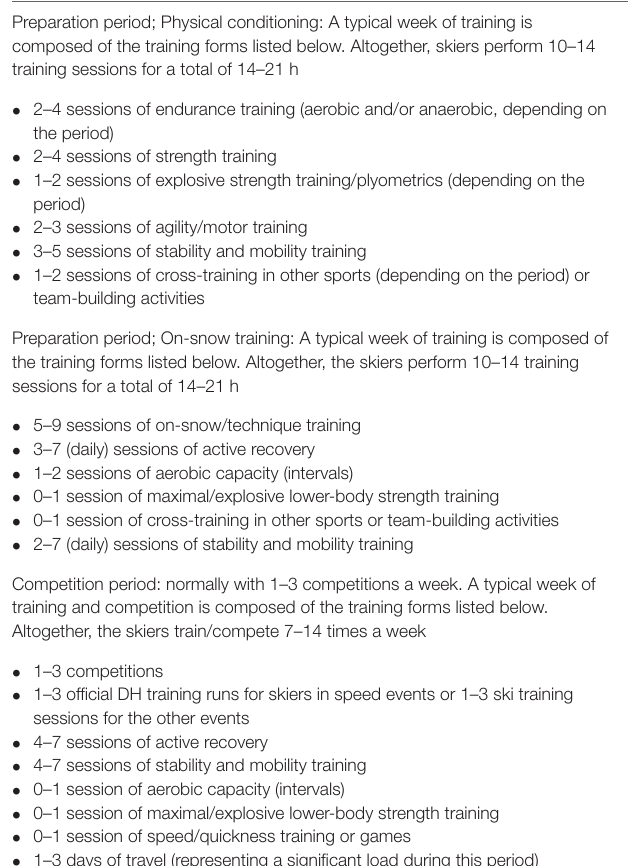
TABLE 2 | The nature and number of weekly sessions of physical conditioning and on-snow training an athlete can choose from during the preparation period and competition